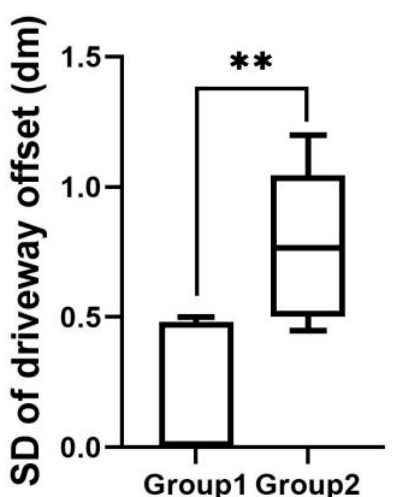
Figure 7. Standard deviation of driveway offset in telephone task. ** indicates significant difference ( p < 0.01).